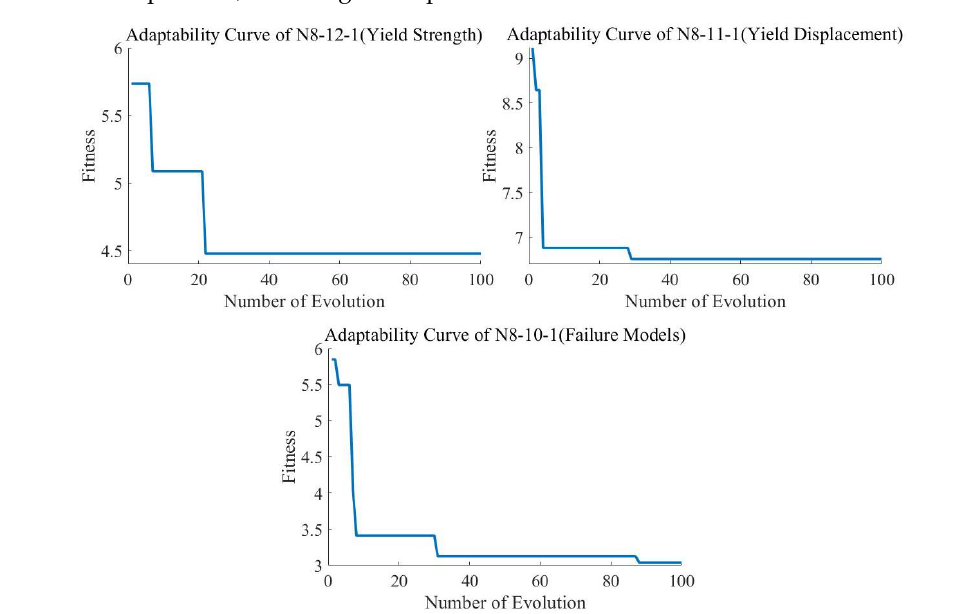
Figure 7. Fitness function optimization process.